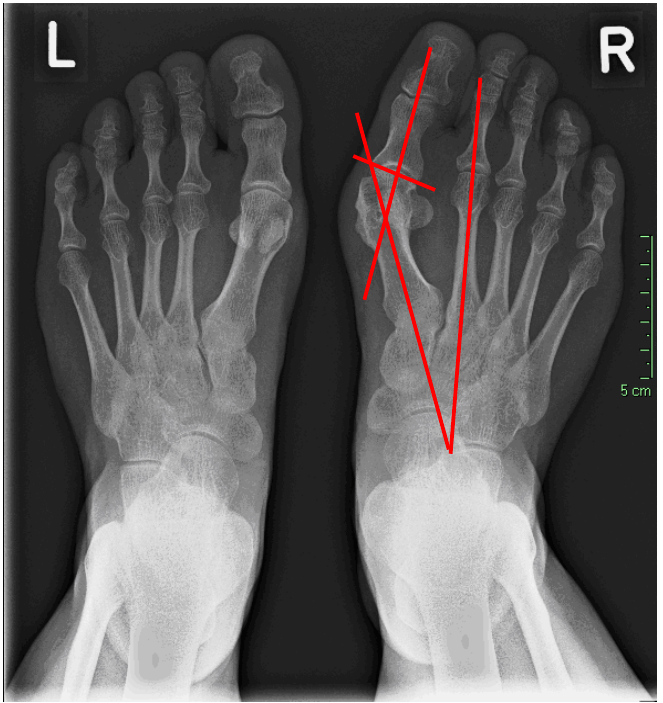
FIGURE 1. Weight-bearing anteroposterior views of both feet. HVA (between the long axes of the first metatarsal and the proximal phalanx) 37°; IMA (between the long axes of the first two metatarsals) 22°; DMAA (between the transverse axis defining the first metatarsal distal articular surface and perpendicular to the long axis of the first metatarsal)